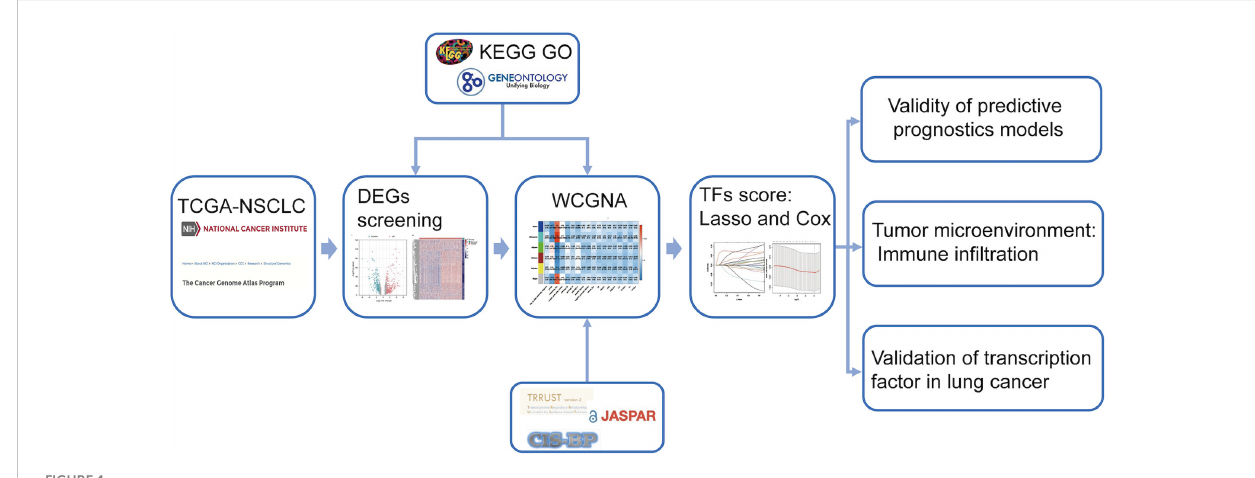
FIGURE 1 Work fl ow of data